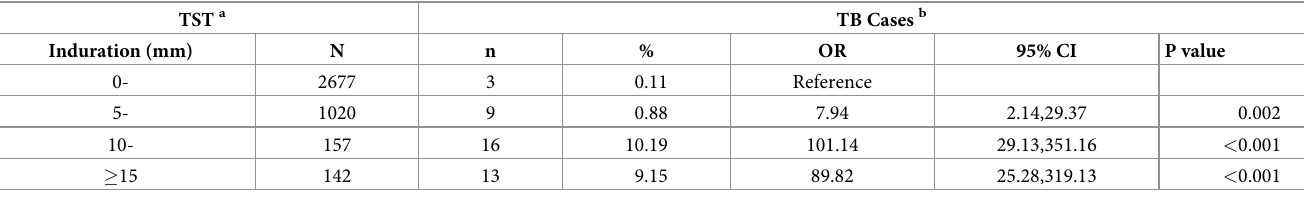
Table 3. TB case detection rate in different TST